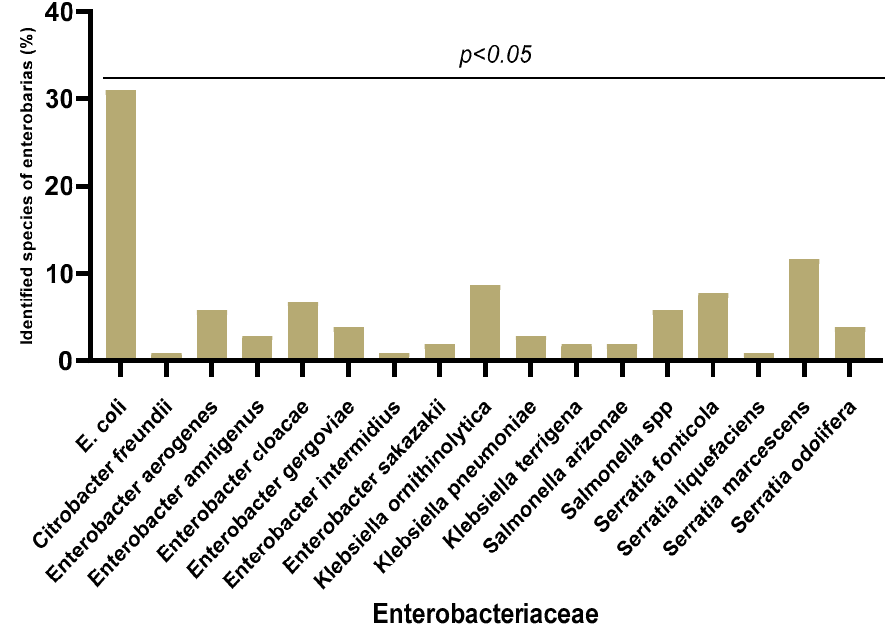
Figure 1. Different Enterobacteriaceae species isolated from urinary tract